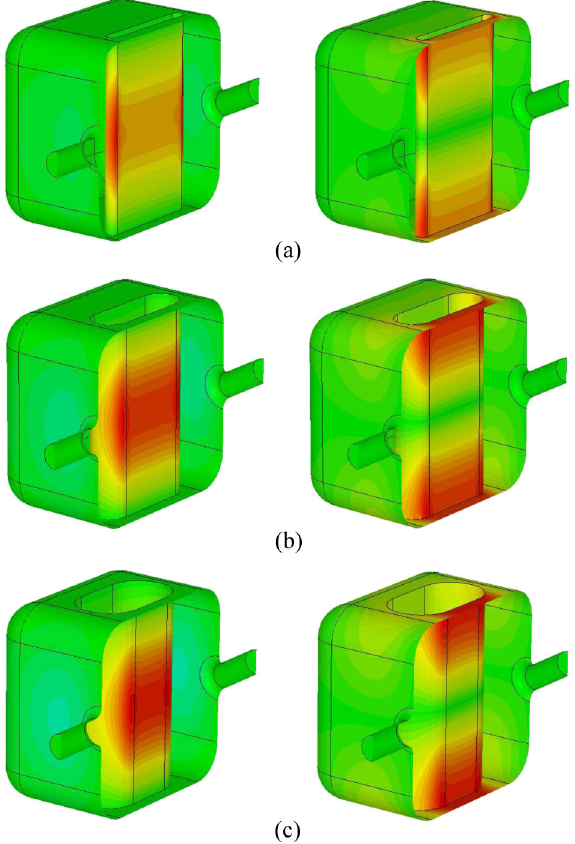
FIG. 15. Surface electric (left) and magnetic (right) field at bar widths of (a) 20 mm, (b) 60 mm, and (c) 100 mm.